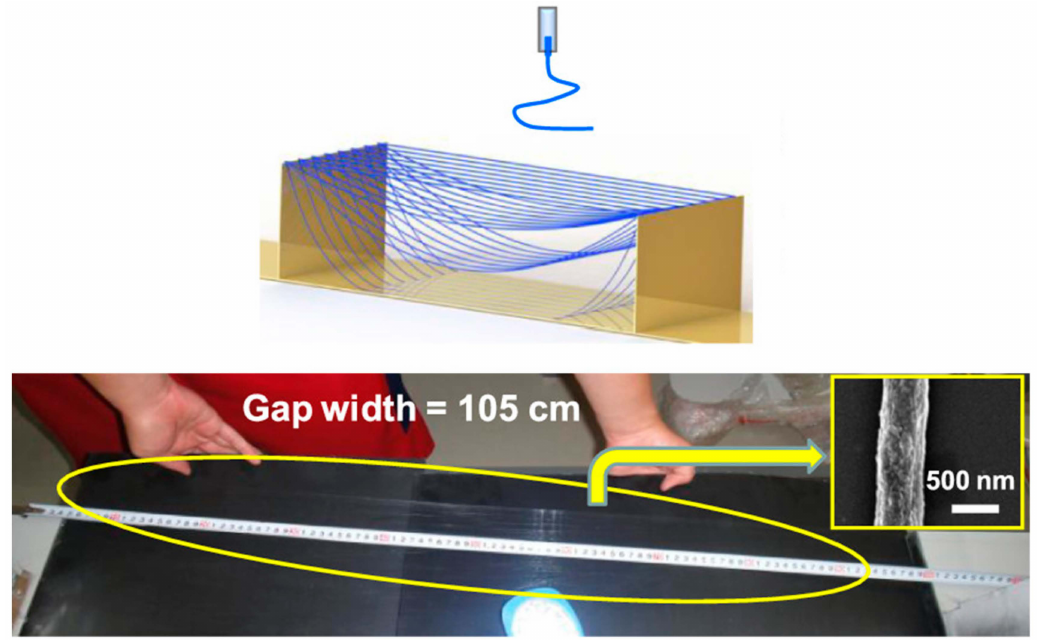
Figure 5. A representation of gap electrospinning and the length of fibers that can be produced by the technique. Adapted with permission from [36], American Chemical Society,